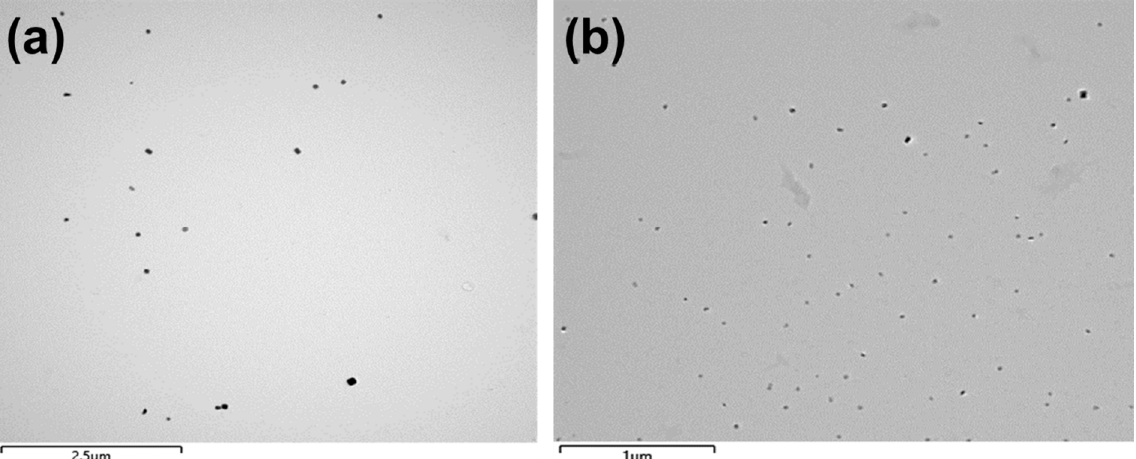
Figure 2. TEM images obtained from carbon extraction replicas showing the precipitates in the studied steels after hot forging: ( a ) steel S1; ( b ) steel S2.